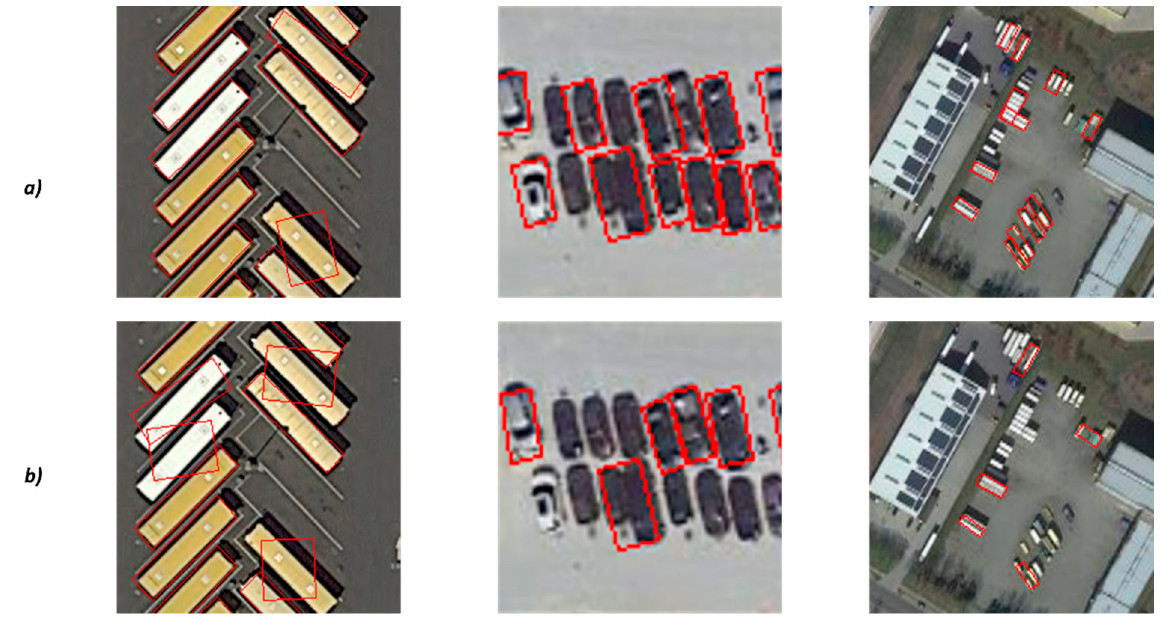
Figure 8. Comparison of partial test results of EFM-Net and Faster R-CNN on the OBB task. ( a ): EFM-Net and ( b ): Faster R-CNN. Table 2. Performance evaluation of the OBB task on the DOTA